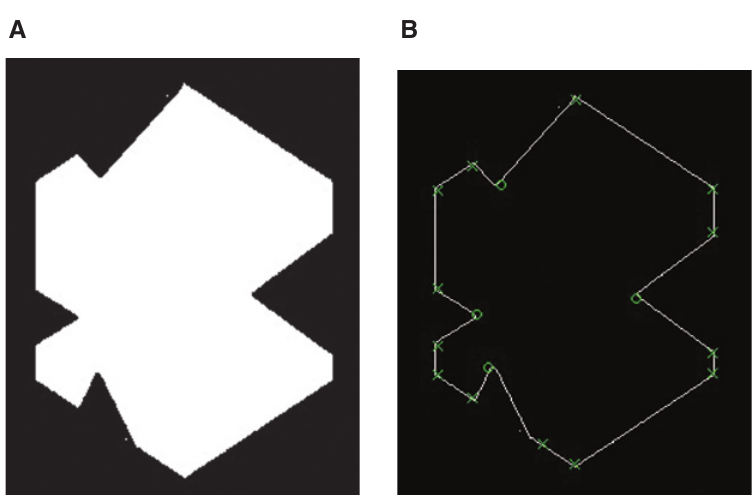
Figure 5: (A, B) Segregation of Concave and Convex Points.